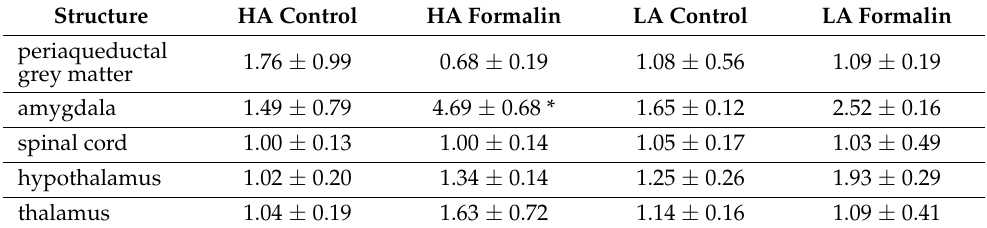
Figure 5. Effect of minocycline (45 and 100 mg/kg, i.p, MIN) on the intensity of acute inflammatory pain in HA ( A ) and LA ( B ) mice ( n = 8) in the formalin test. Paw licking was scored following intraplantar injection of 5% formalin (in PBS) into the dorsum of the hind foot. Minocycline was injected 30 min before formalin. Paw licking time was measured in the interphase (INT, 5–20 min) and the second phase (2nd, 20–60 min) of the test. Results were analysed within each line and phase with two-way ANOVA followed by Bonferroni’s post-hoc test. Statistical significance was depicted as follows: * p ≤ 0.05; *** p ≤ 0.001 (vs. control within each phase). Table 6. Allograft inflammatory factor 1 (Aif1) mRNA levels in HA and LA mice in the interphase of the formalin test. Mice were injected with 5% formalin (in PBS) into the dorsal aspect of the hind paw ( n = 4–6). Samples were harvested 15 min post-formalin. Results were analysed within each line with two-way ANOVA followed by Bonferroni’s post-hoc test. Statistical significance was depicted as follows: * p ≤ 0.05 (vs. control).